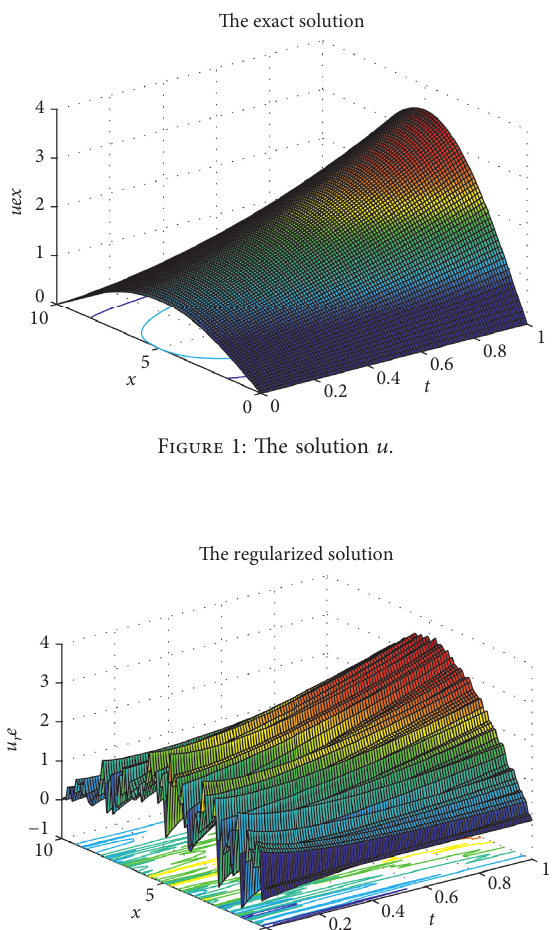
Figure 2: The regularized solution in the case of ε